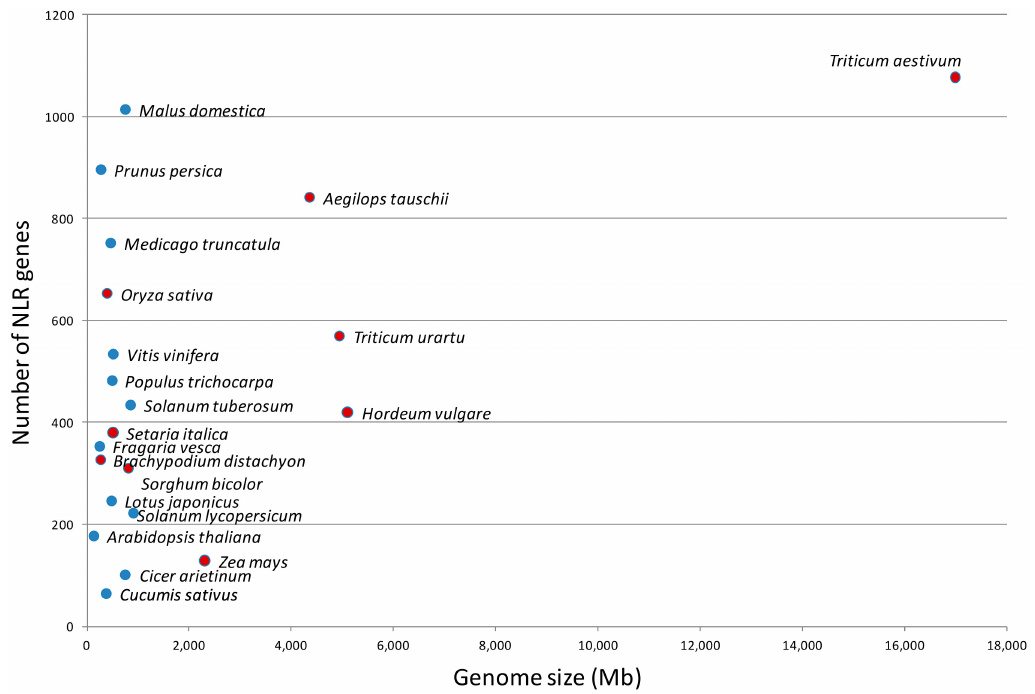
Figure 1. Number of NOD-like receptor (NLR) genes in relation to genome size in some monocot (red) and dicot (blue)